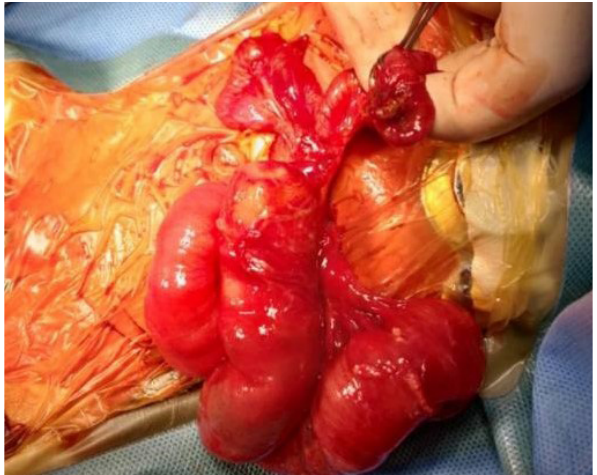
Figure 3. Proximal dilated bowel with small caliber of distal ileum.